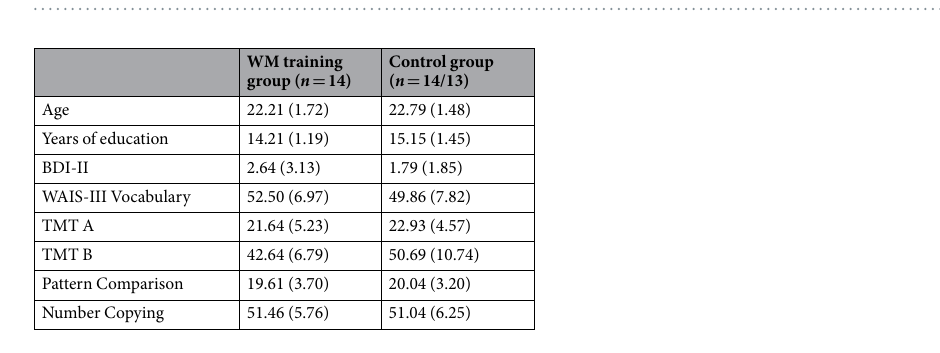
Table 2. Descriptive data on the study groups (means and SD ). Note. BDI = Beck Depression Inventory, WAIS = Wechsler Adult Intelligence Scale, TMT = Trail Making Test. Age in years, BDI-II scores, WAIS-III Vocabulary raw scores, TMT completion time in sec, Pattern Comparison and Number Copying raw scores ( SD s in parentheses). One participant in the control group had missing data on years of education, one participant in the control group had unreliable performance data on the Pattern- Comparison task, and one participant in the control group was an extreme outlier in TMT B (hence, n = 13 in the control group for these